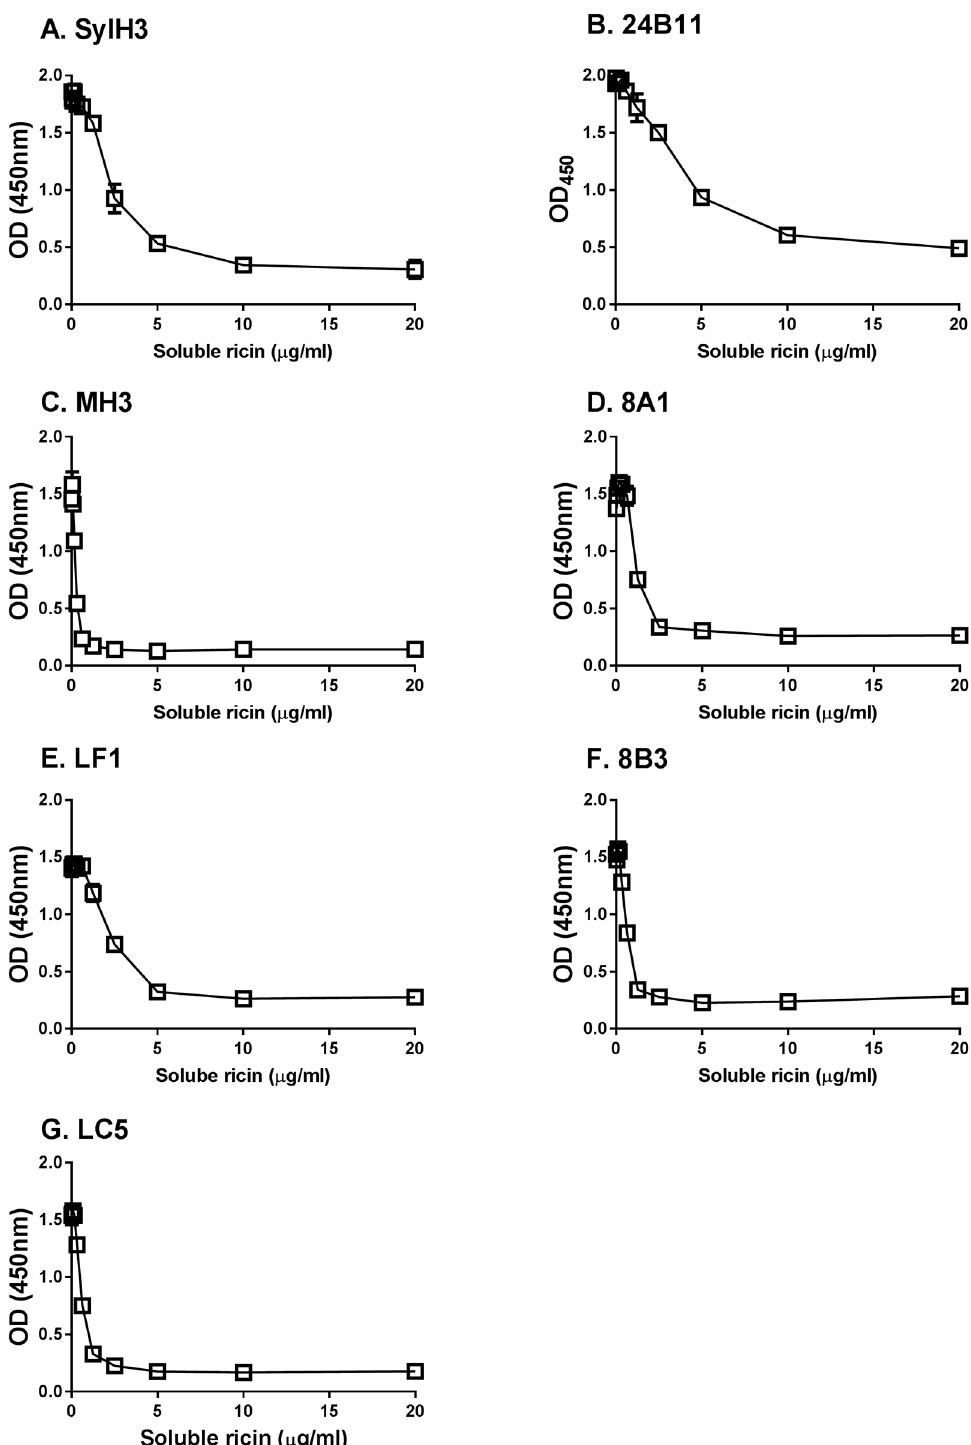
Fig 2. Recognition of soluble ricin by RTB-specific mAbs. IndividualRTB-specific mAbs (panels A-G) were mixed with serial dilutionsof solublericin (as indicatedon the x-ordinate),then appliedto ricin-coatedmicrotiter plates. The plates were developed with an HRP-labeled goat anti-mouse IgG-specific secondaryantibody and TMB substrate to detect amount of mAb bound in each well (y-ordinate). The results shown are a single representative experiment in which each sample was done in duplicate. Error bars, when visible, reflect the variation between technicalreplicates.